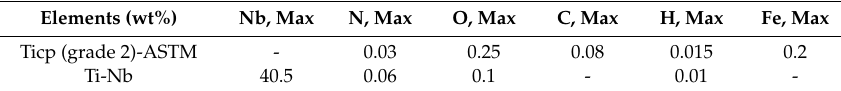
Table 1. Elemental analysis of